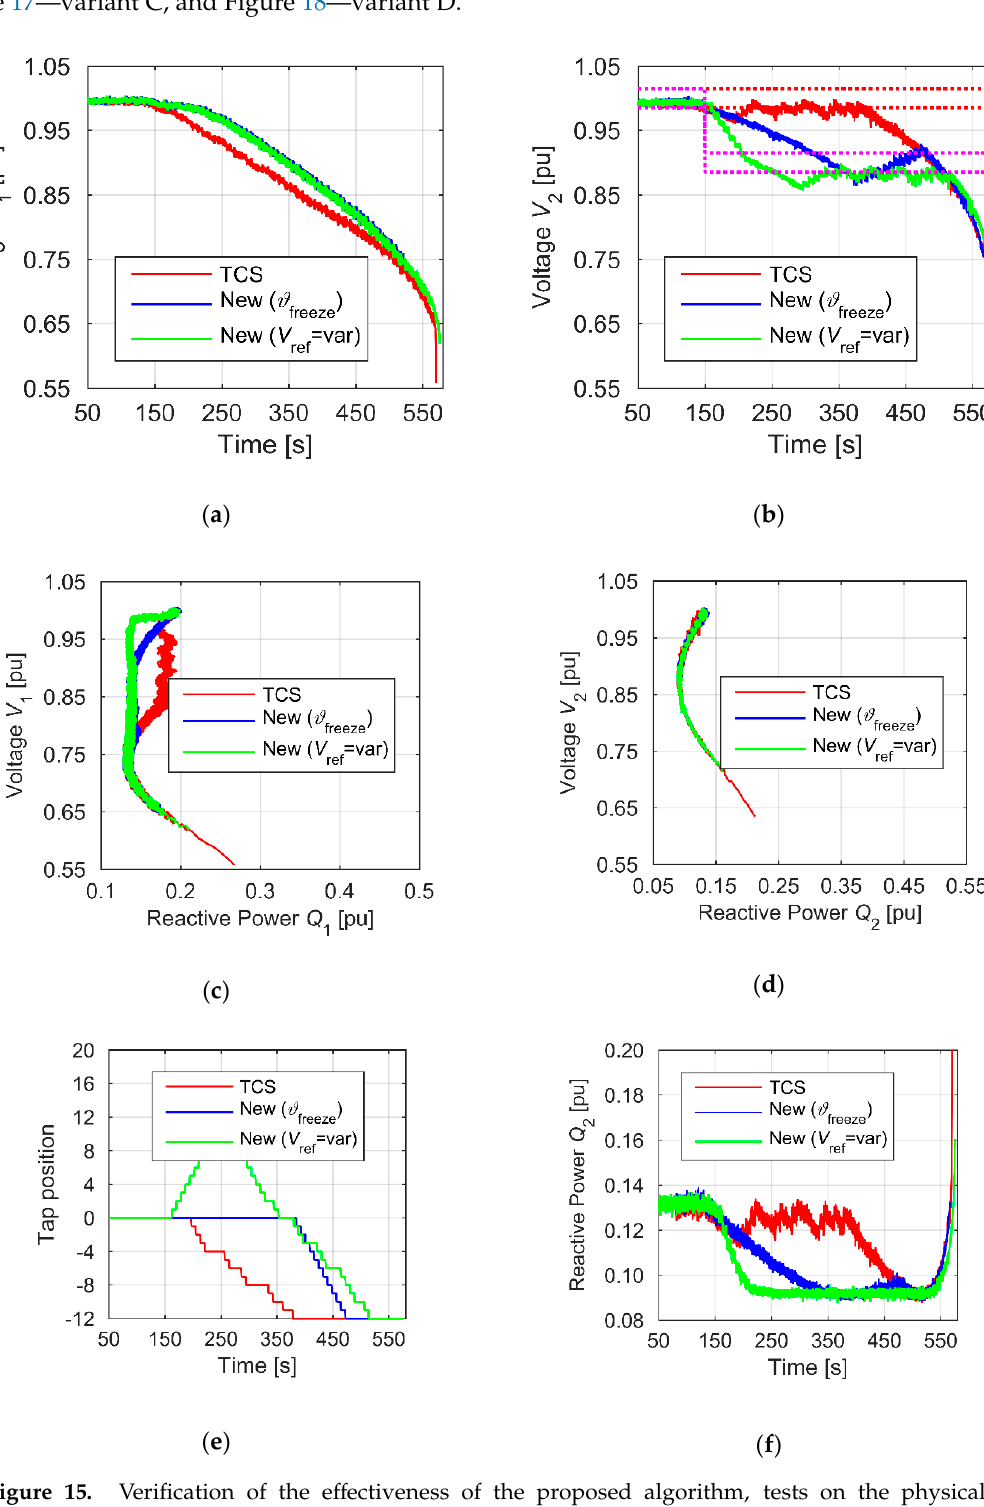
Figure 15. Verification of the effectiveness of the proposed algorithm, tests on the physical model—variant A: ( a ) voltage V 1 ; ( b ) voltage V 2 ; ( c ) characteristics V 1 = f( Q 1 ); ( d ) characteristics V 2 = f( Q 2 ); ( e ) tap position; ( f ) reactive power Q 2 .